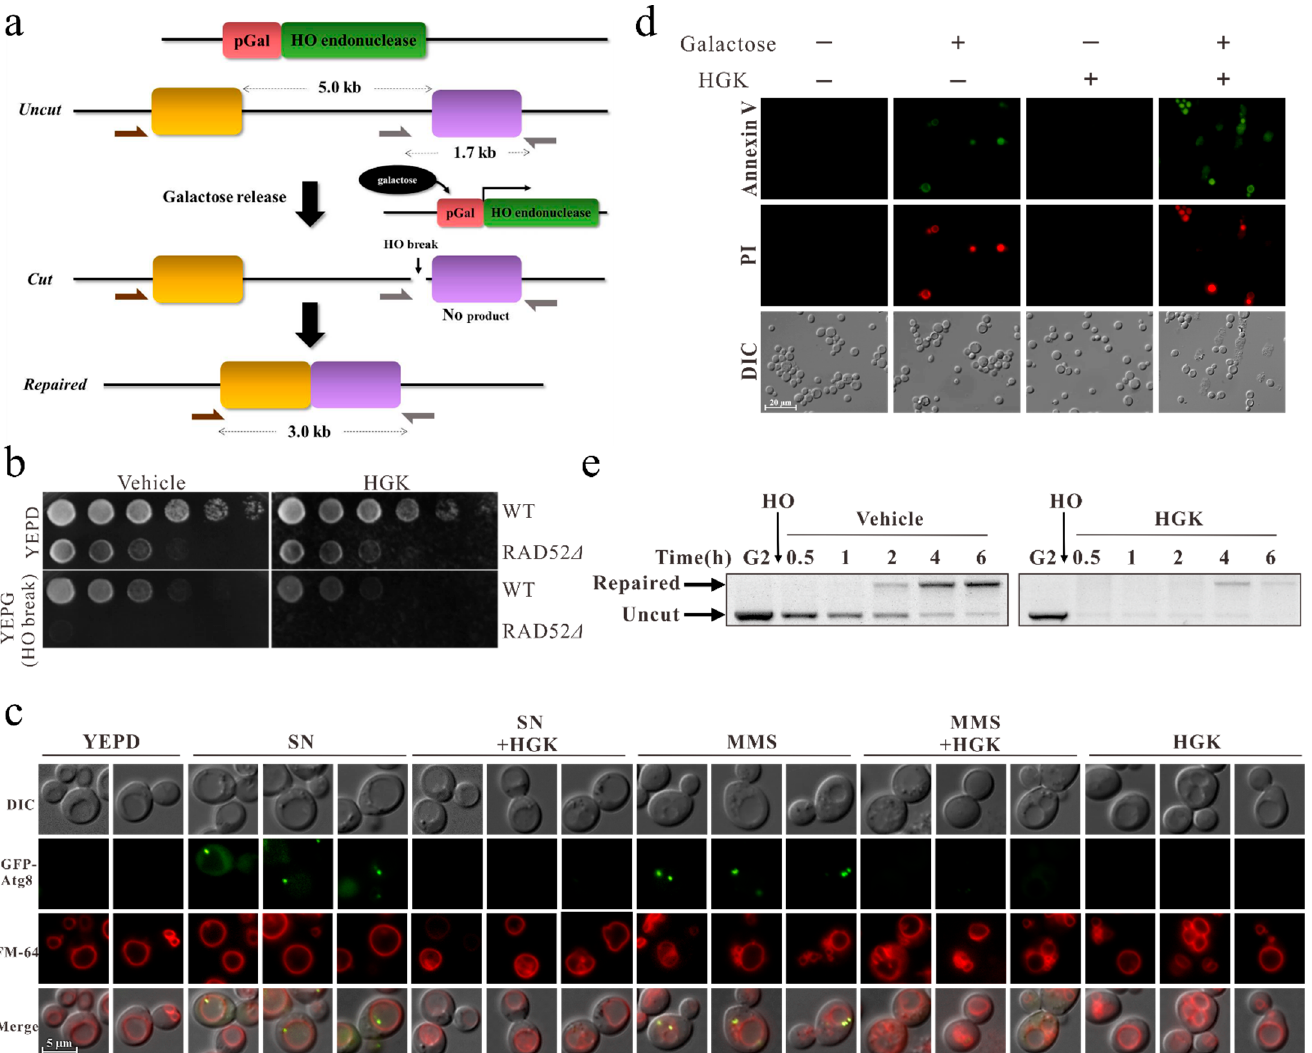
Figure 1. Hydroxygenkwanin (HGK) inhibits DDR in yeast cells and promotes apoptosis. ( a ) Schematic representation of the single-strand annealing (SSA) analysis system. Galactose-induced HO endonuclease results in the generation of specific double-strand DNA breaks in a defined location (HO break). The effect of HGK on double-strand break repair (DSBR) was analyzed by polymerase chain reaction (PCR) using the indicated primers. ( b ) Five-fold serial dilution analysis shows the sensitivity of the WT (YMV045) and RAD52 ∆ (YMV046) strains to HGK and double-strand DNA breaks. ( c ) The GFP-ATG8 yeast cells (RLY004 strain, transformed with a plasmid containing a green fluorescent protein fused with ATG8) were cultured in yeast extract peptone dextrose growth medium, nitrogen starvation (SN), MMS (0.1%), HGK (2 mM), SN + HGK, and MMS + HGK for 4 h. Samples were stained with FM4-64 and processed for fluorescence microscopy. DIC served as controls, and all scale bars represent 5 μ m. ( d ) Yeast cells (YMV045) were treated with 2 mM HGK in the presence or absence of 2% galactose for 48 h, and cell apoptosis was determined by Annexin V/PI staining. ( e ) A double-strand DNA break was induced in YMV045 cells by galactose. The effect of HGK on DSBR was examined by PCR. MMS: methyl methanesulfonate; DIC: differential interference contrast microscopy.